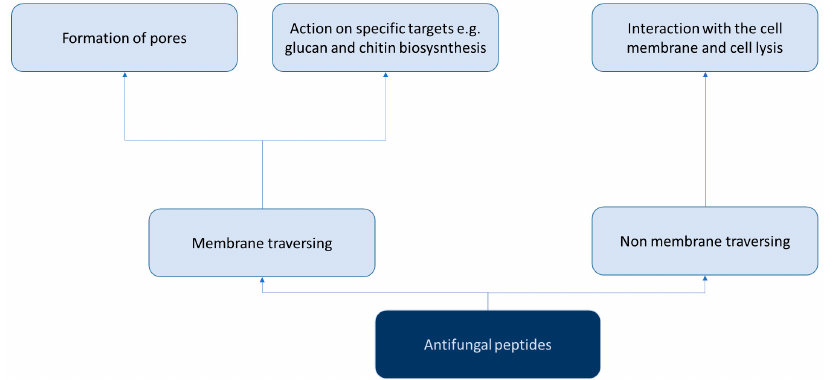
Figure 1. Scheme of the classification of antifungal peptides according to the mechanism of action in general.